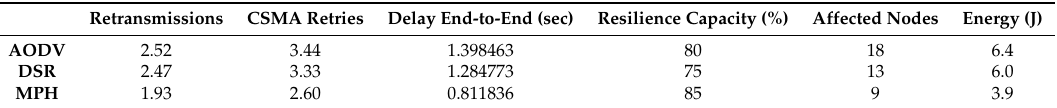
Table 5. Performance metrics under attack and Scenario 3 when the jammer is in the middle of the